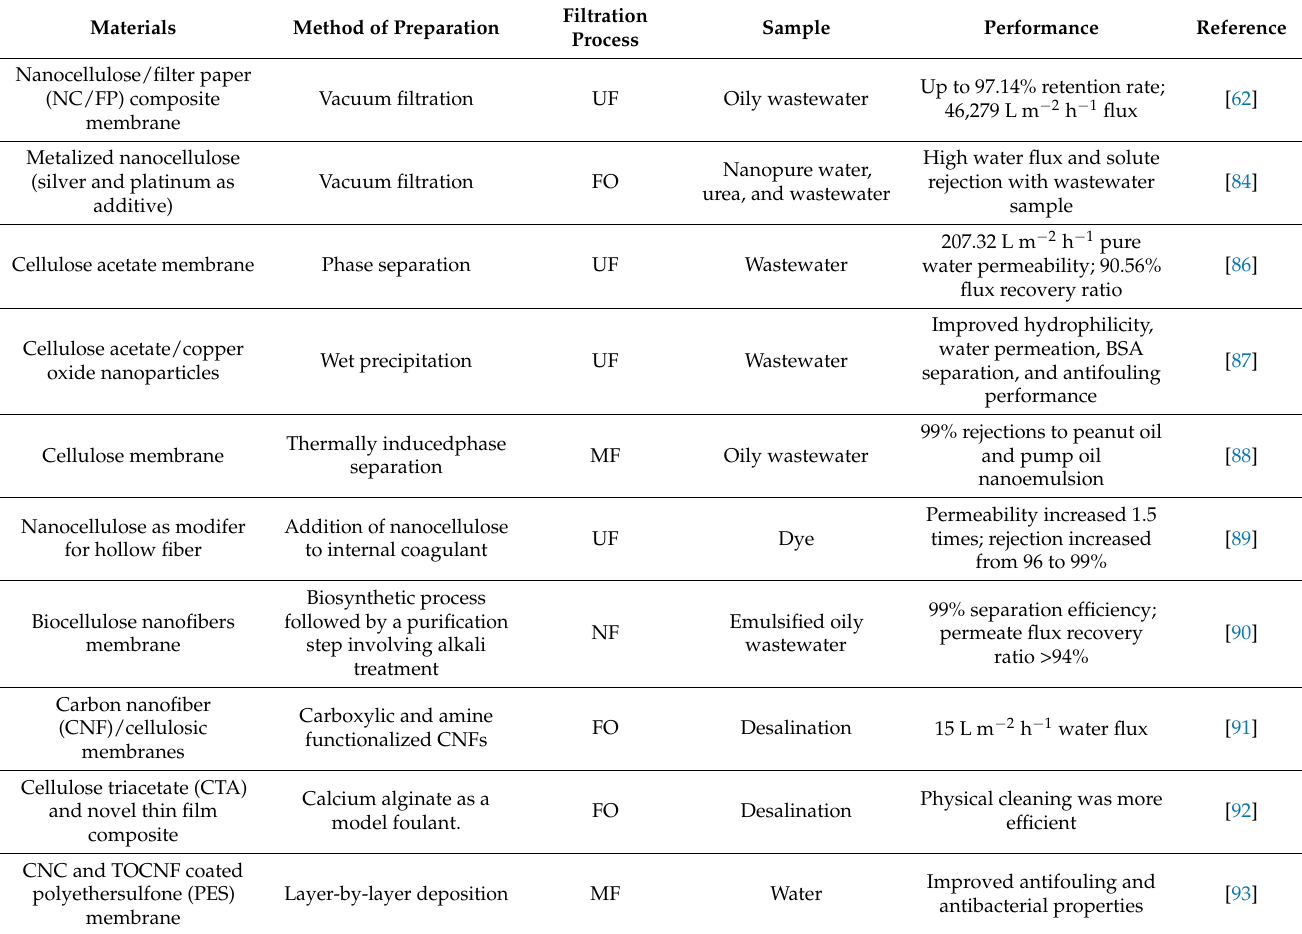
Table 3. Different types of nanocellulose-based membranes for water